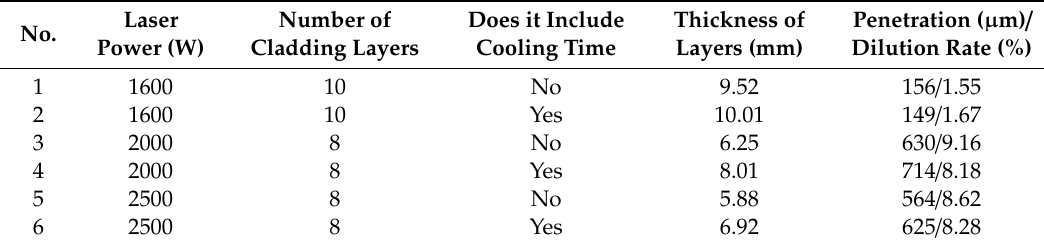
Table 3. Experimental parameters, thickness of layers, and depth of penetration.